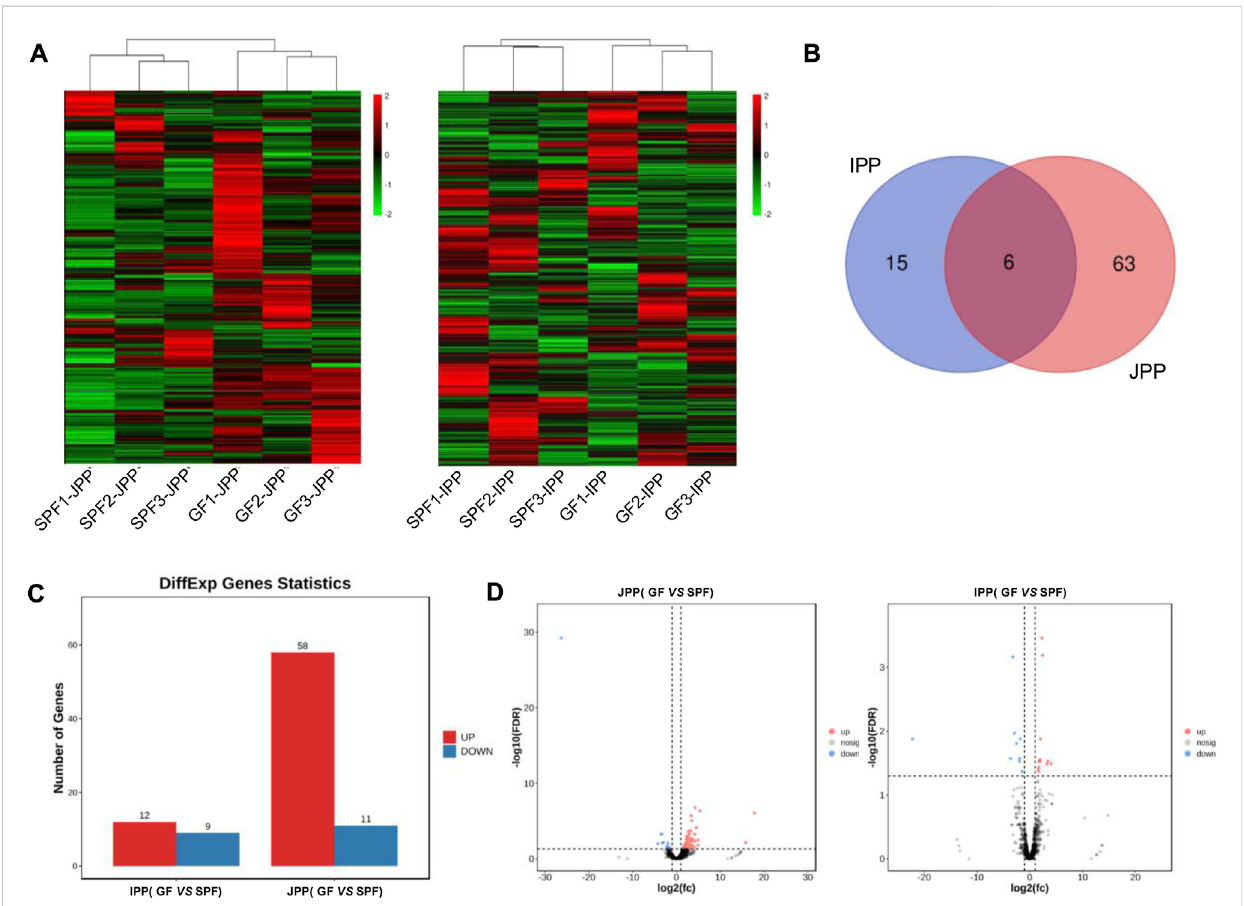
FIGURE 7 Commensal microbiota regulates lncRNA expression in piglet PPs. (A) Hierarchical clustering based on global expression pro fi les of lncRNAs in IPPs or JPPs. (B) The shared and speci fi c DE lncRNAs in IPPs and JPPs. (C) The numbers of upregulated and downregulated DE lncRNAs in JPPs and IPPs. (D) The DE lncRNAs in JPPs and IPPs were analyzed and visualized via volcano plotting. n = 3.